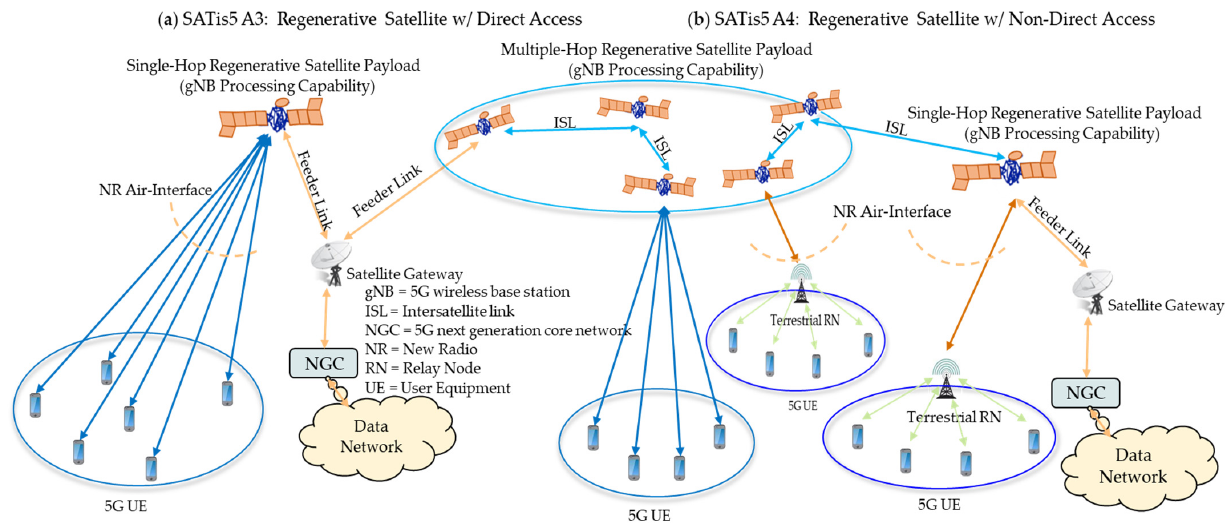
Figure 4. SATis5 Single-Hop Transparent Satellite Payload: ( a ) Direct Access SATis5 A1, and ( b ) Non-Direct Access SATis5 A2.